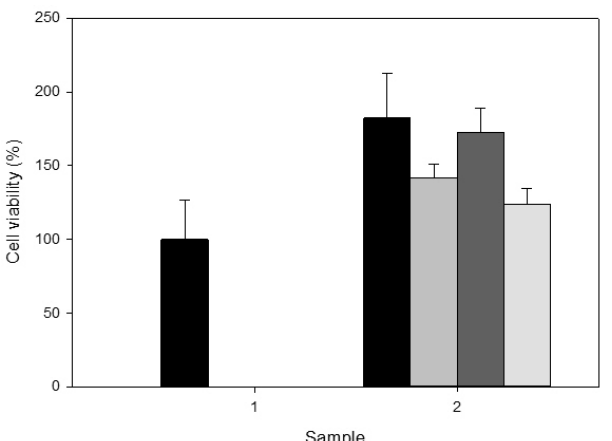
Figure 10. Cell viability of HCEC after incubation with poly(HEMA) and poly(HEMA, BAC) nanoparticles for 2 days at 37 °C and 5% CO 2 . Samples shown are the control with no nanoparticles (1) and poly(HEMA) nanoparticle formulation A1 (2) from Table 1. The bars correspond to original concentration ( ■ ), 2× dilution ( ■ ), 4× dilution ( ■ ), and 8× dilution ( ■ ). Error bars were obtained from the standard error of triplicate samples.